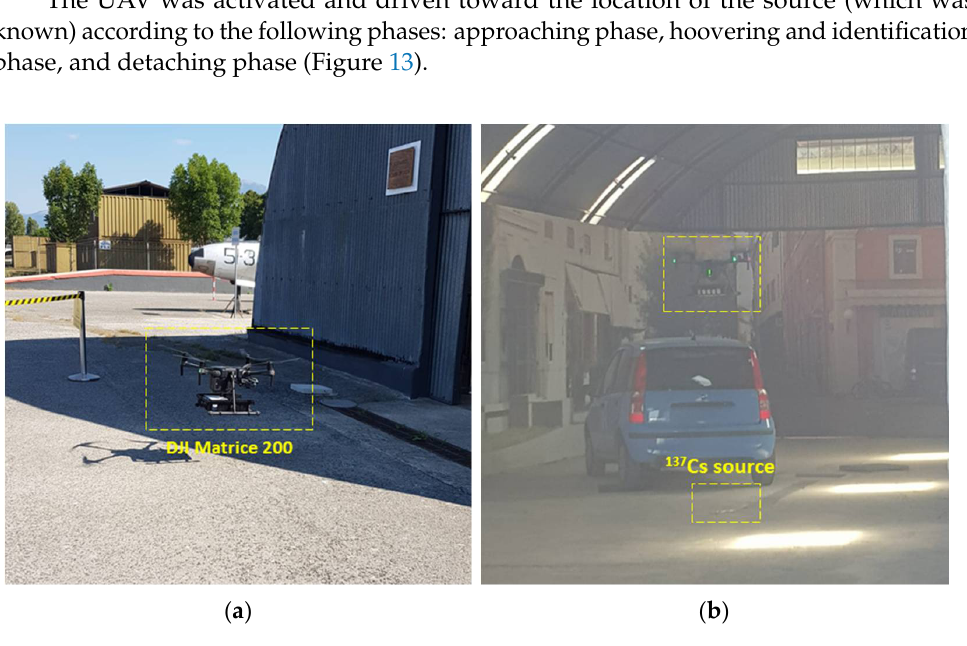
Figure 12. Intrinsic photopeak efficiency at different energies for module A ( a ) and module B ( b ).